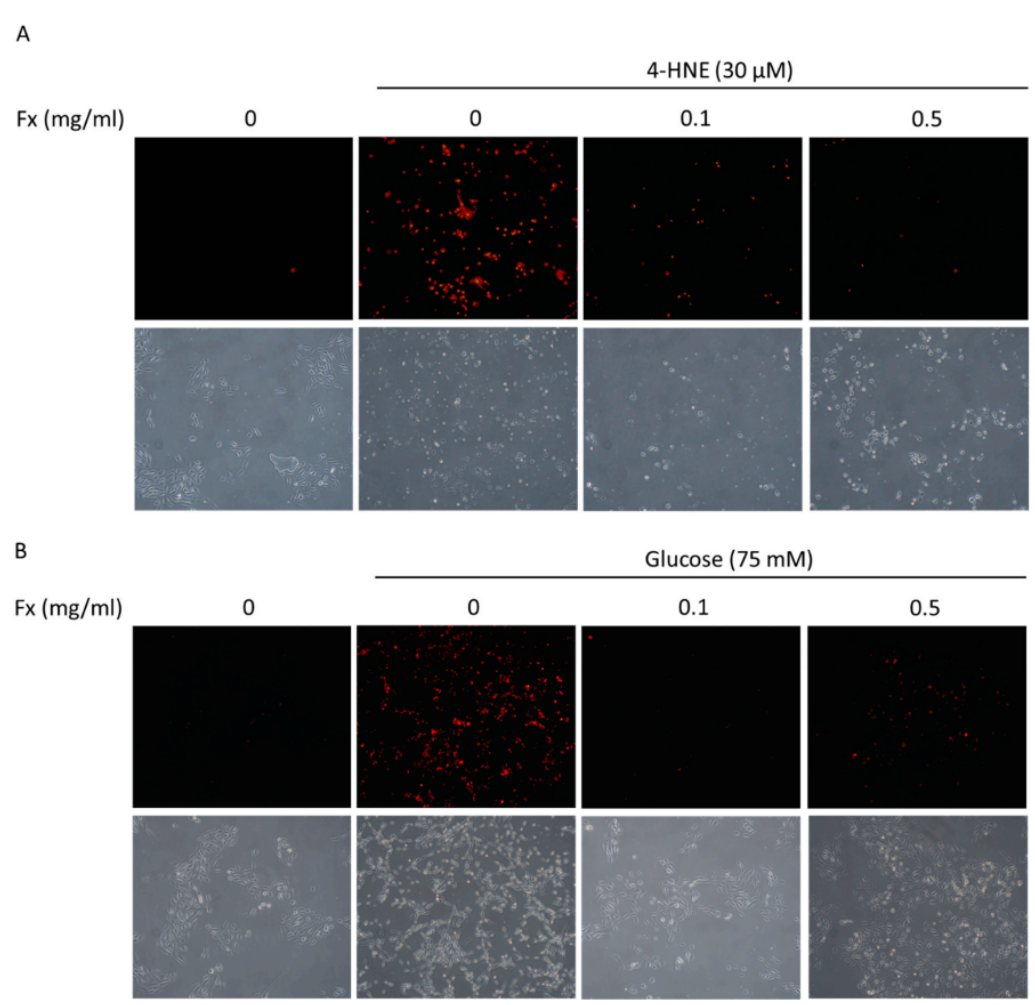
Figure2. E ff ectsoffucoxanthin(Fx)on4-HNE-andhighglucose-inducedARPE19cellpropidiumiodide (PI) staining and morphology changes. ARPE19 cells were cultured in DMEM F12 for 24 h after serum free starvation for 18 h. This was combined with fucoxanthin induced by ( A ) 30 µ M 4-hydroxynonenal (4-HNE) for 24 h or ( B ) 75 mM glucose for 72 h. We used PI staining and photographed with a microscope at 20 ×